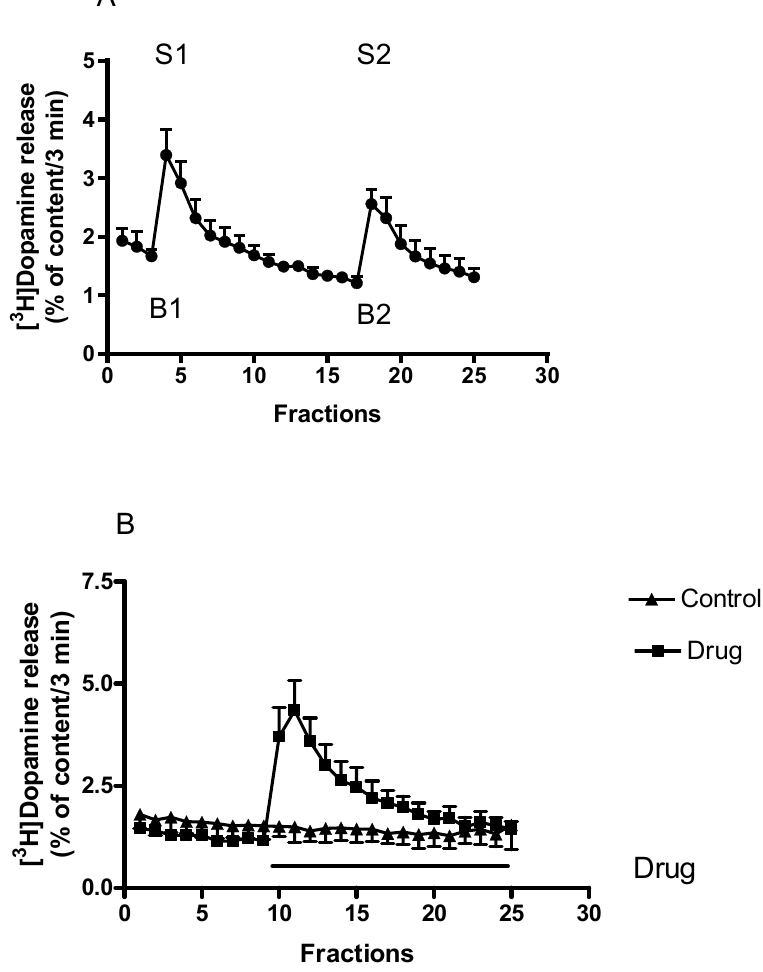
Figure 2. ( A ) The time-course of [ 3 H]dopamine release measured from rat striatum. Filled circles indicate [ 3 H]dopamine release at rest and in response to electrical stimulation. Striatal slices were prepared, loaded with [ 3 H]dopamine and superfused with aerated Krebs-bicarbonate buffer. [ 3 H]Dopamine release was induced by electrical stimulation (40 V, 2 Hz, 2 msec for 3 min) in frac- tions 4 (S1) and 18 (S2) and was expressed as a fractional rate, i.e., a percentage of the amount of [ 3 H]dopamine in the tissue at the time of the release. The calculated ratio of the electrically stimu- lated fractional release S2 (2nd stimulation) over fractional release S1 (1st stimulation) (S2/S1) was 0.84 ± 0.04, representing a release of vesicular origin. The calculated ratio of resting fractional release B2 (fraction17) over fractional release B1 (fraction 3) (B2/B1) was 0.72 ± 0.05. When studied, drugs